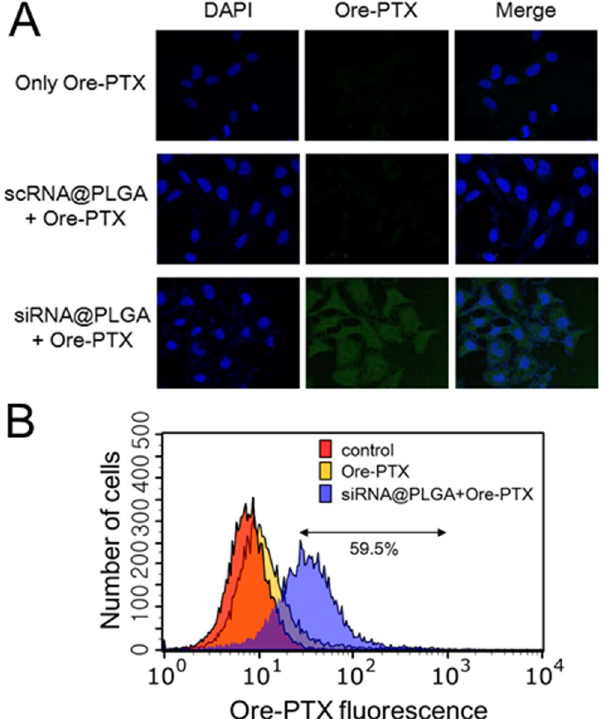
Figure 5. Increased intracellular concentration of drugs on siRNA@PLGA NPs-pretreated MDR cancer cells. ( A ) Confocal microscopic images demonstrating the suppression of drug efflux on MDR SKOV3-TR cells. Cells were first pretreated with siRNA@PLGA NPs, and 24 h later, administrated with 0.1 μ M fluorescent paclitaxel conjugates (Oregon green-488 paclitaxel, Ore-PTX) for monitoring their intracellular localization. Cellular confocal microscopic evaluation was carried out 12 h after drug treatment. As a control, suppression of drug efflux by the scrambled siRNA@PLGA NPs was also compared. ( B ) Flow cytometry analysis for measuring the intracellular accumulation of fluorescent paclitaxel conjugates on SKOV3-TR cells. A prefixed gate region was allowed only for Oregon green-488 fluorescence. A representative histogram among three independent experiments was shown